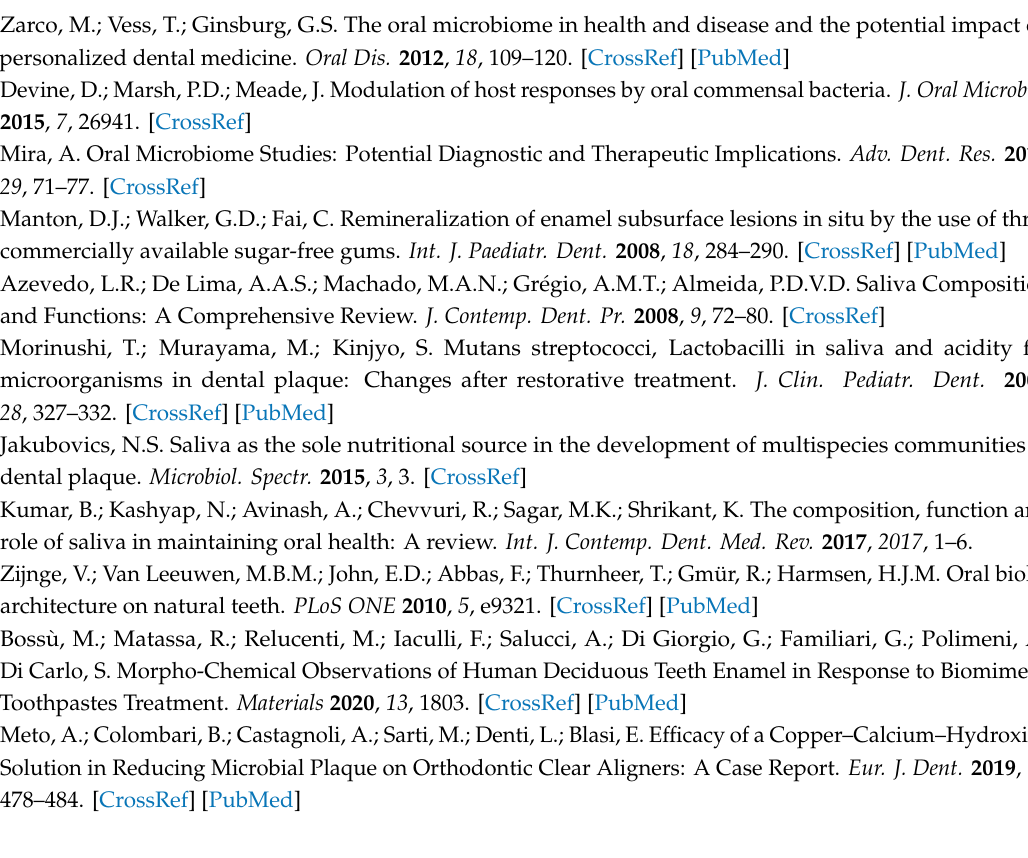
Figure S1: Flow-chart of the saliva